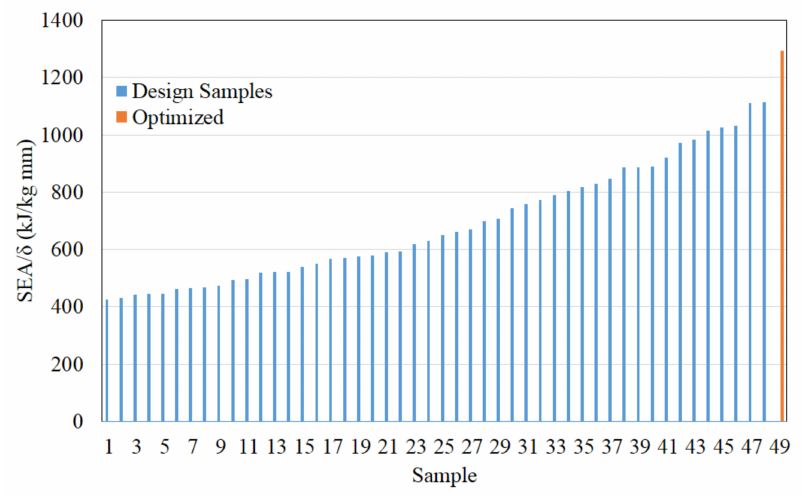
Figure 18. The ratio of energy absorption to the deformation to measure optimization